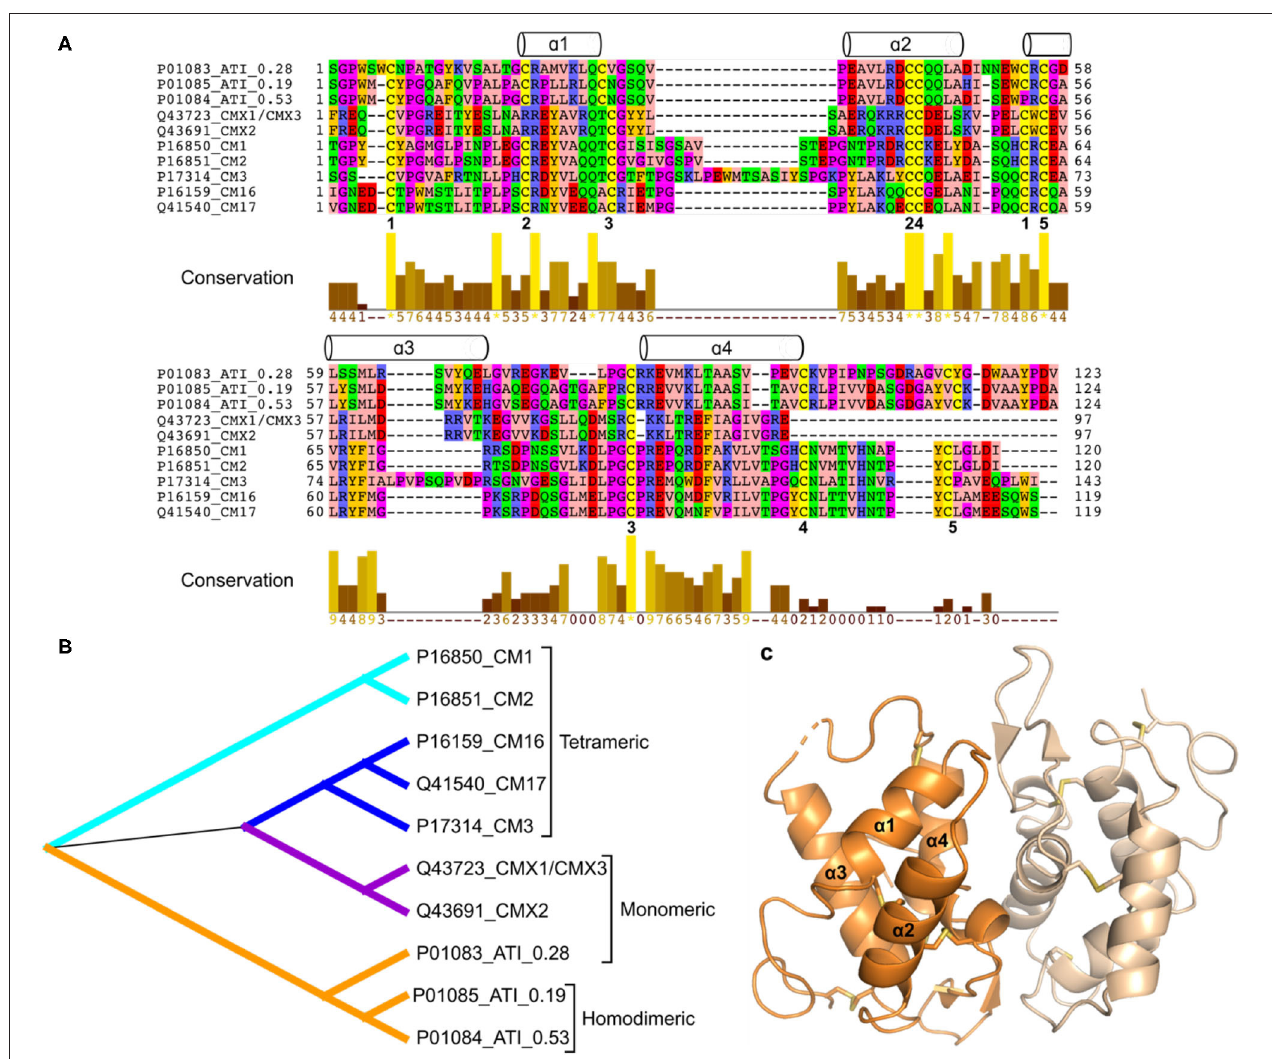
FIGURE 2 | (A) , Multiple sequence alignment including wheat ATIs (signal peptides have been removed). The wheat ATIs only share very few fully conserved positions including some of the disulphide bonds (numbered 1–5 below the alignment). The α -helices above the alignment indicate the secondary structure elements based on the 3D structure of ATI 0.19 (part C ), and the alignment is colored according to amino acid properties. (B) , Phylogenetic tree generated based on alignment shown in (A) . (C) , Three-dimensional structure of wheat homodimeric ATI 0.19 [PDB entry 1HSS (11)]. Although only one 3D structure has been determined for 0.19, and the sequence identity is low, all wheat ATIs are predicted to share the following overall structure: four α -helices connected by irregular loop regions and stabilized by disulphide bonds (a four- α -helix bundle). Software used: MEGA X (12) (Muscle for alignment preparation and Maximum likelihood for phylogenetic